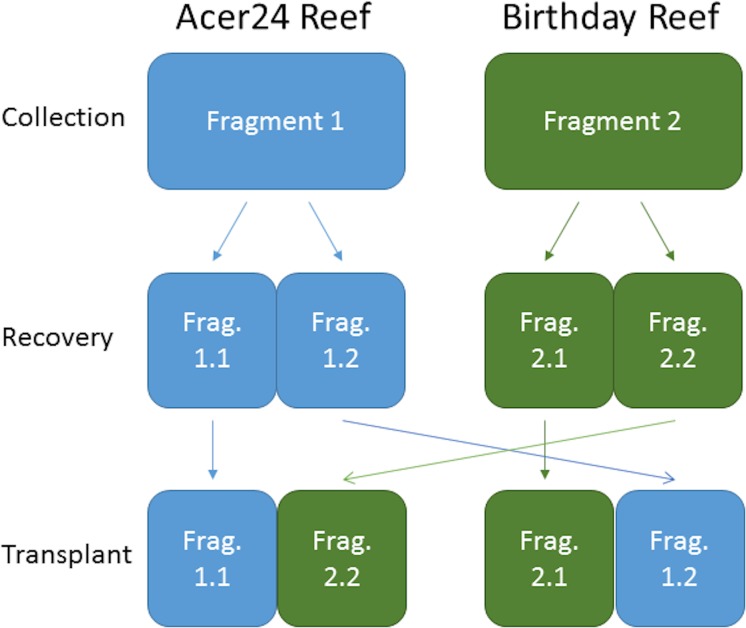
Graphical representation of reciprocal transplant sampling design.A 16x16 cm fragment of P. astreoides was collected from each reef. This fragment was sectioned into two 16x8 cm small fragments and allowed to recover. Coral was then placed back onto a reef with one small fragment being placed at its reef of origin, while the other fragment half was transplanted to the companion site. For the above, fragments colored in blue originated from Acer24 Reef, while the fragments colored in green originated from Birthday Reef. The above was repeated ten times for each reef, for a total of n = 20 P. astreoides sampled and n = 40 small fragments placed back on to reefs.